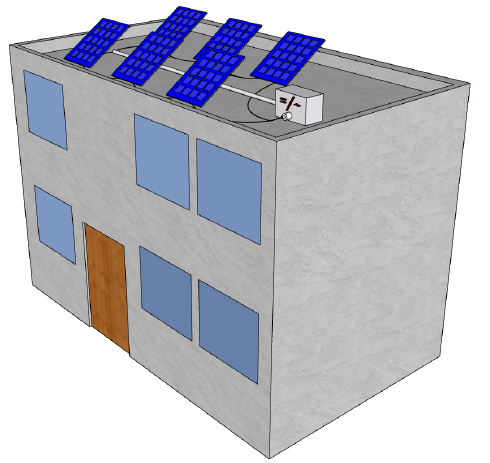
Figure 1. Example of a rooftop PV installation made up of 6 solar panels all connected to the same